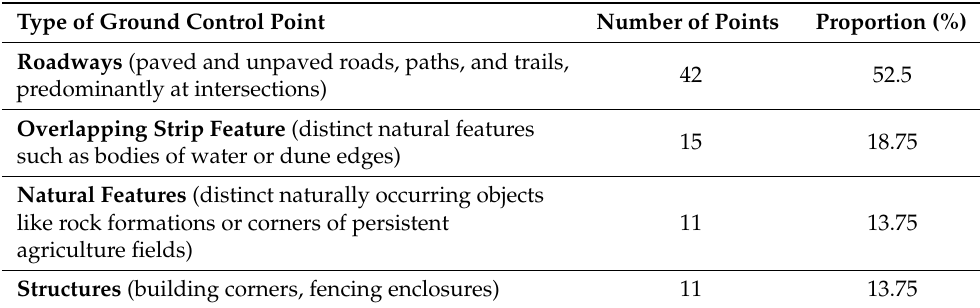
Table 2. Distribution of sampling across different types of ground control points.